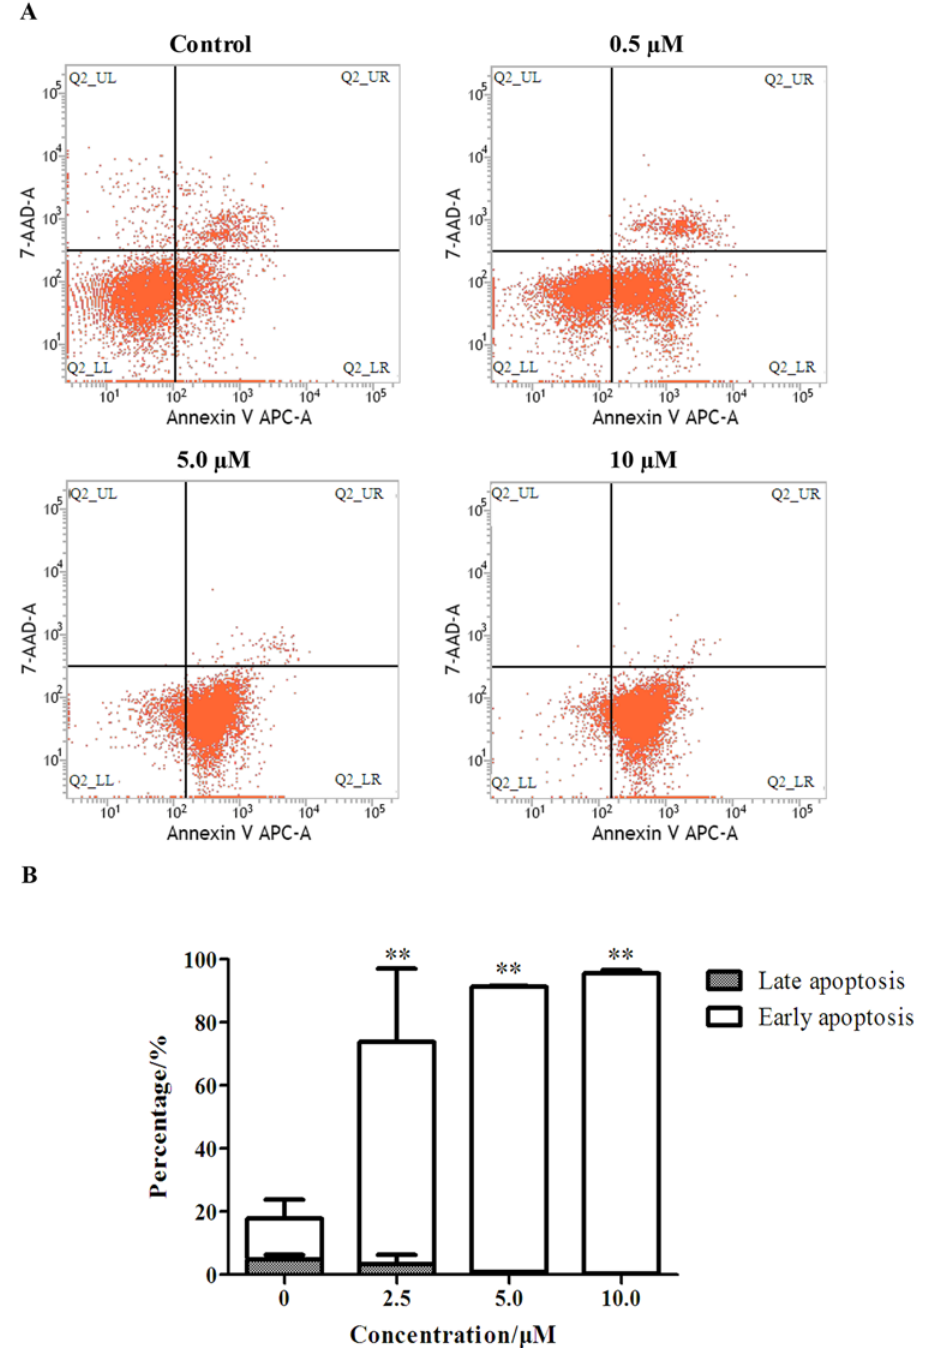
Fig 8. Flow cytometry analysis of apoptosis of OVCAR-3 cells treated with EM-d-Rha. OVCAR-3 cells were incubated for 72h with EM-d-Rha at 0, 2.5 μ M, 5 μ M, 10 μ M, respectively. And cells were stained with FITC conjugated Annexin V and 7-AAD. A: Representative dot plots of Annexin V-FITC/7-AAD staining. a: control, 72h; b: 2.5 μ M EM-d-Rha, 72h; c: 5 μ M EM-d-Rha, 72h; d: 10 μ M EM-d-Rha, 72h. B: Data pooled from three independent experiments show the percentage of apoptotic cells. Difference was considered statistically significant when * p < 0.05 and ** p < 0.01 vs control group .